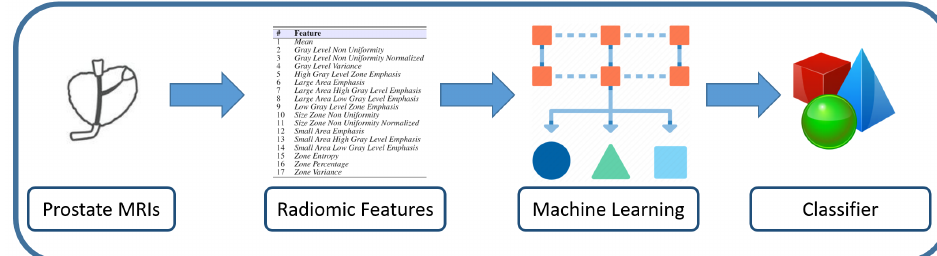
Figure 1. Training